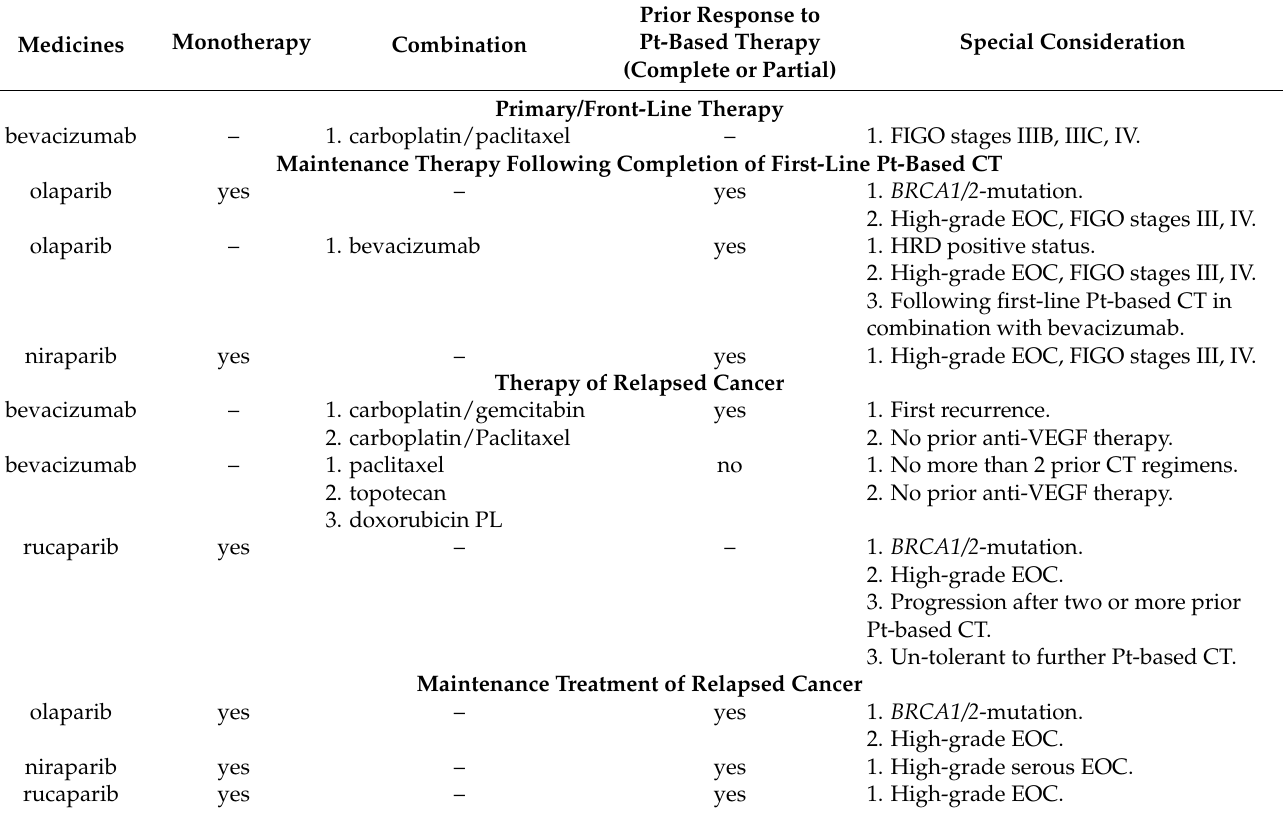
Table 1. Therapeutic indications of targeted therapy in advanced epithelial OC approved by European Medicines Agency (EMA)